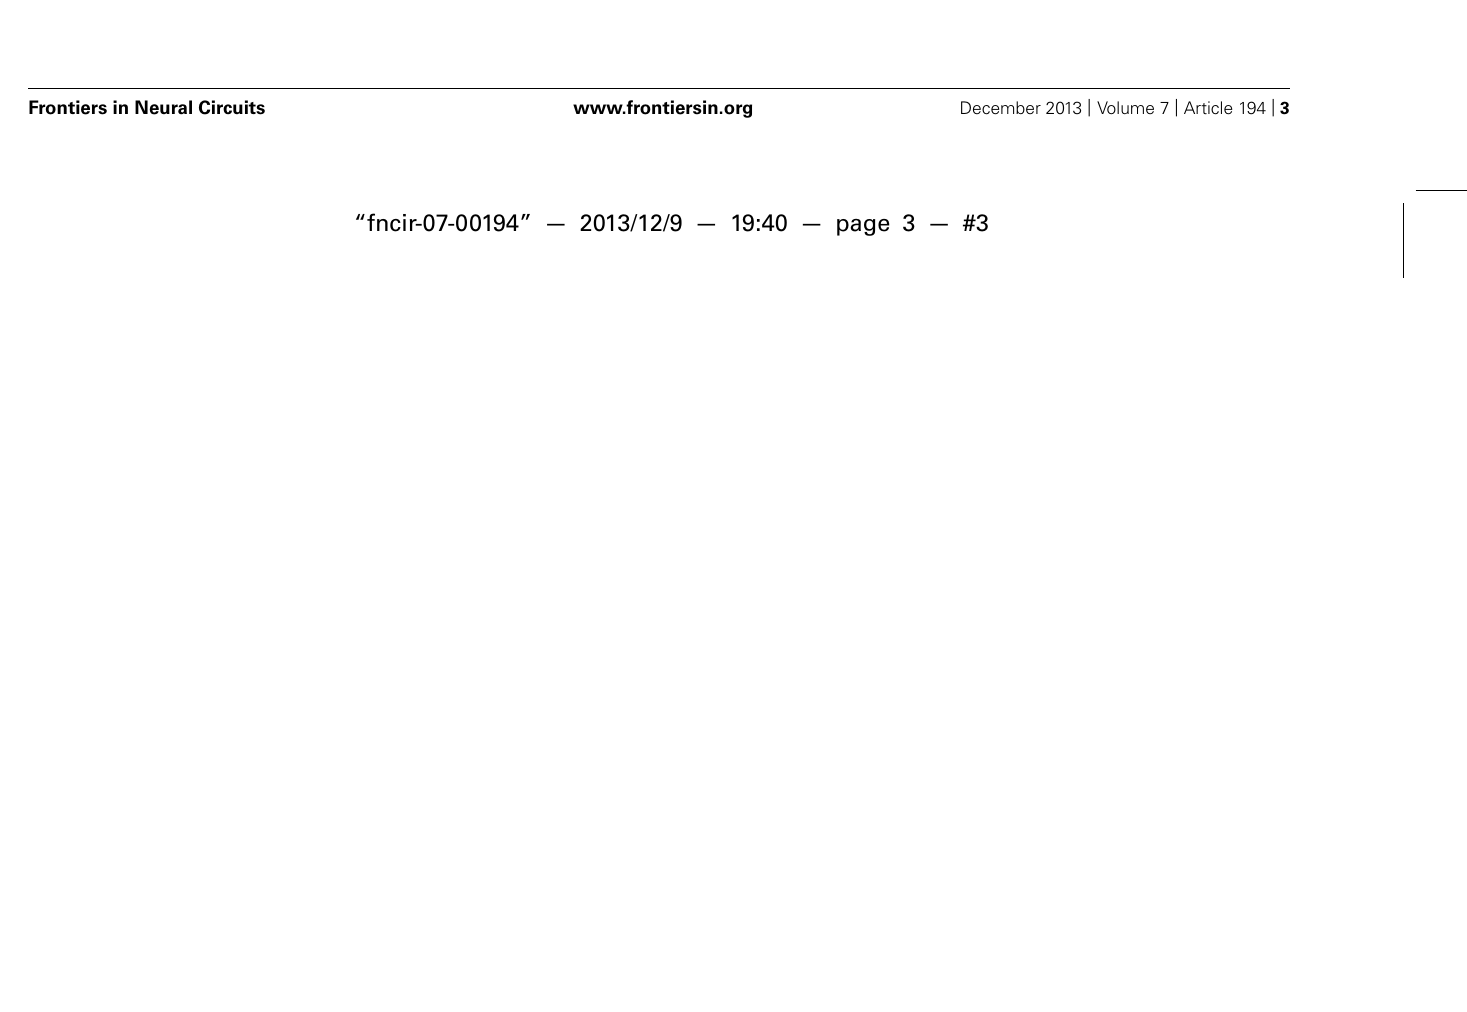
the resetting is equal to φ − 1. (C) Stimulus and recovery intervals in the network. Inset shows closed loop configuration with feedback. In an alternating firing pattern, each spike affects the timing of the very next spike ( k = 1) in the same neuron via a feedback loop through the partner neuron. In a phase-locked mode with constant firing intervals, the gray shaded area indicates that the stimulus interval in neuron 1 is equal to the recovery interval in neuron 2 plus twice the delay δ , and the pink shaded area illustrates a similar constraint for the stimulus interval in neuron 2.The time lags, or firing intervals between neurons, can be inferred from the stimulus and recovery intervals. (D) . Predicting closed loop modes with open loop data. Plotting the algebraic combination of intervals with quantities that must be equal in a phase-locked mode on the same axis ensures that the intersections represent the stimulus and recovery intervals in phase-locked modes.The delay was 20% of the intrinsic period P 0 .The axes are all normalized by the intrinsic period of the component oscillators and therefore